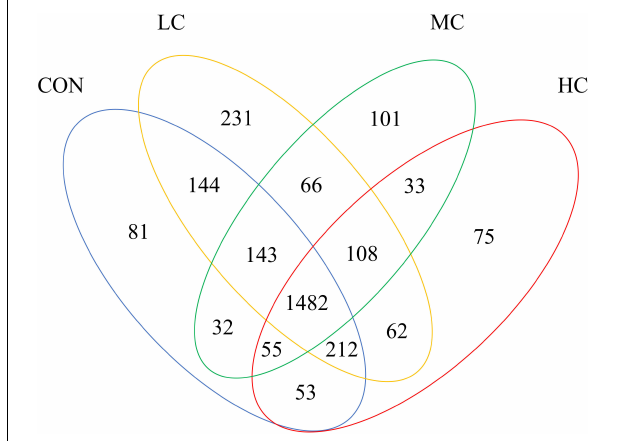
FIGURE 1 | Venn diagram of ruminal fluid